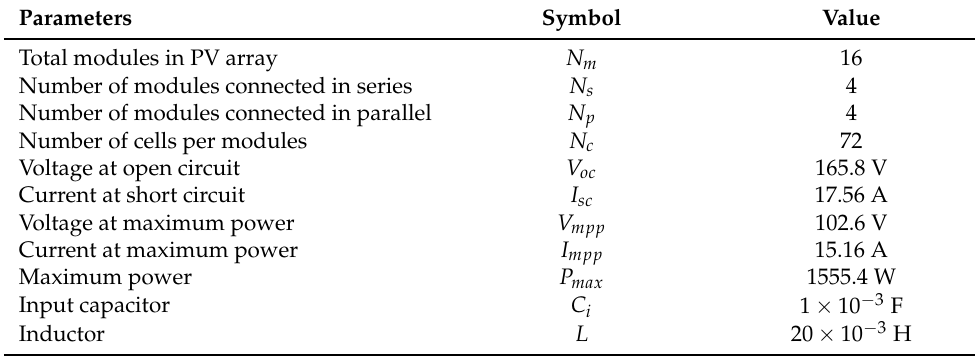
Table 1. PV array parameters [34].